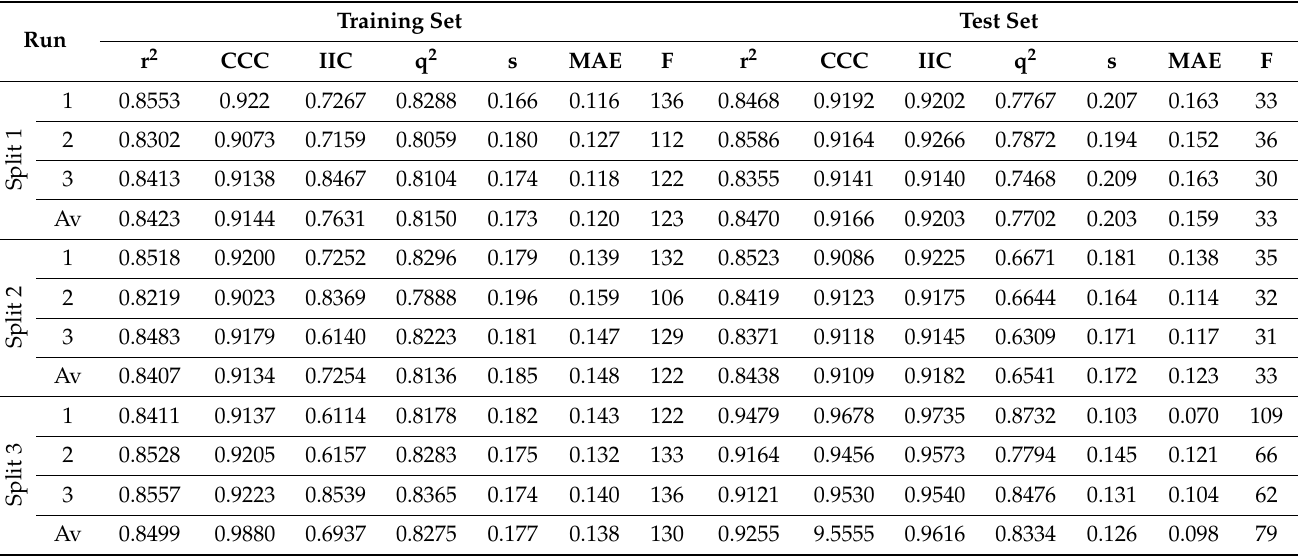
Table 1. The statistical quality of QSAR models developed with the Monte Carlo optimization method for selective positive allosteric modulation of α 1-containing